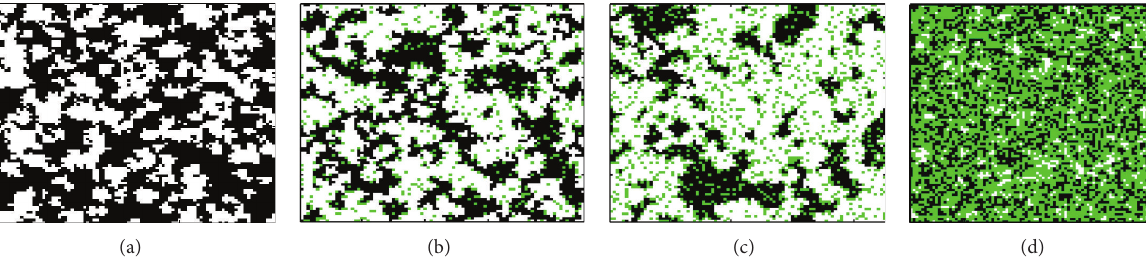
Figure 4: Snapshots of typical distributions of cooperators (white), defectors (black), and empty sites (green) on the square lattice for different values of 𝜌 when 𝑏 = 1.15 , 𝜇 = 0.5 , and 𝛼 = 3.0 : (a) 𝜌 = 1.0 ; (b) 𝜌 = 0.9 ; (c) 𝜌 = 0.8 ; (d) 𝜌 = 0.4 .